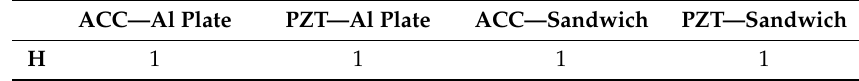
Table 3. Lilliefors normality test results.